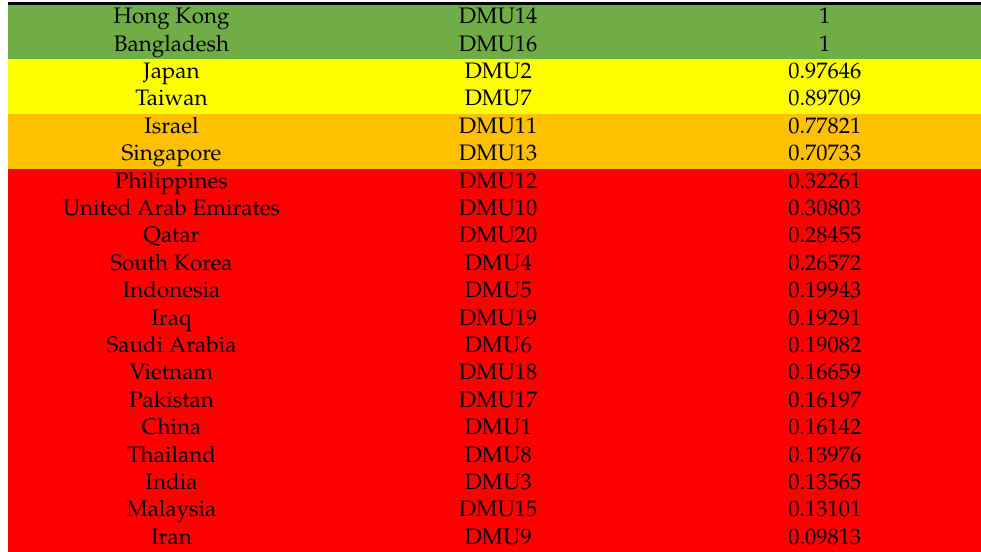
Table 6. Classification into categories based on average environmental efficiency for the top 20 GDP Asian economies in the period 2005–2019. Source: Authors’